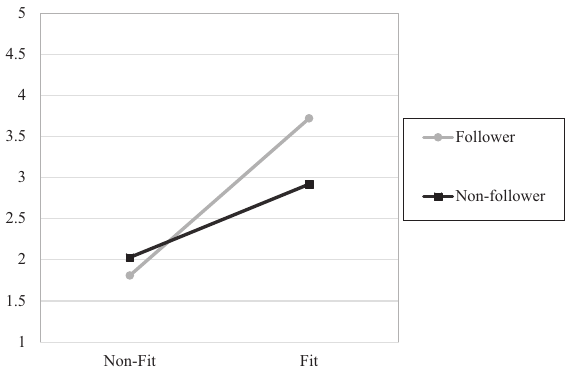
Figure 2. Interaction